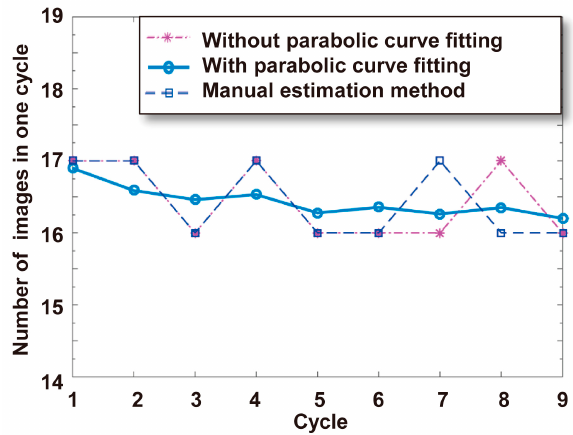
Figure 11. The number of images in each cycle. The data “Without parabolic curve fitting” represent the number of images between two adjacent peak points of the maximum correlation coefficient sequence. The data “With parabolic curve fitting” are the number of images between two maximum points of the adjacent parabolic curves. The data “Manual estimation method” were obtained by observing and comparing the video images frame by frame.